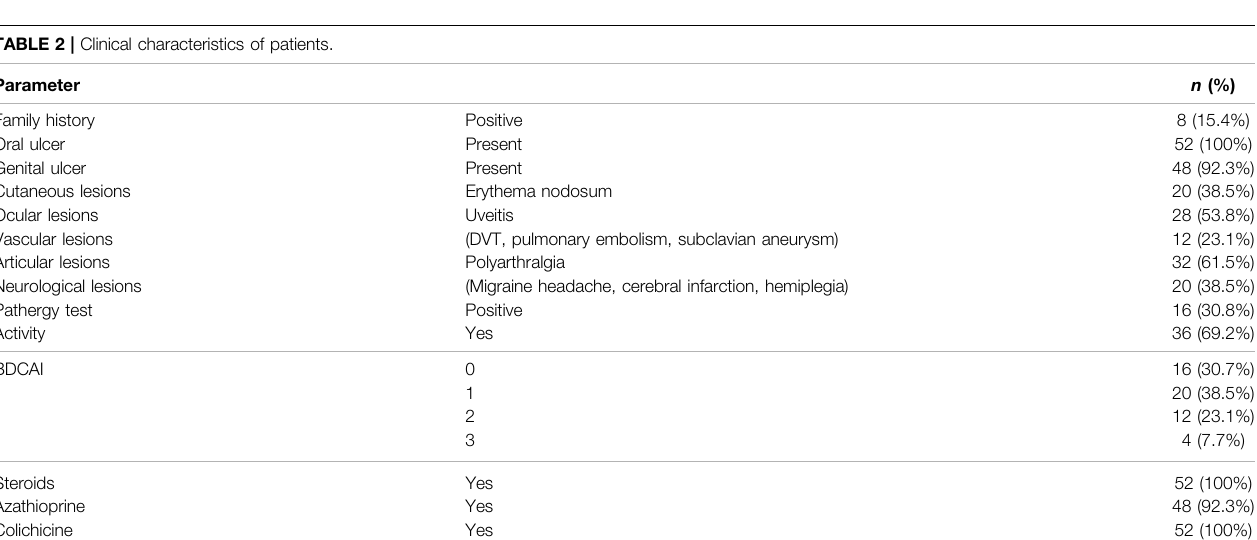
TABLE 2 | Clinical characteristics of